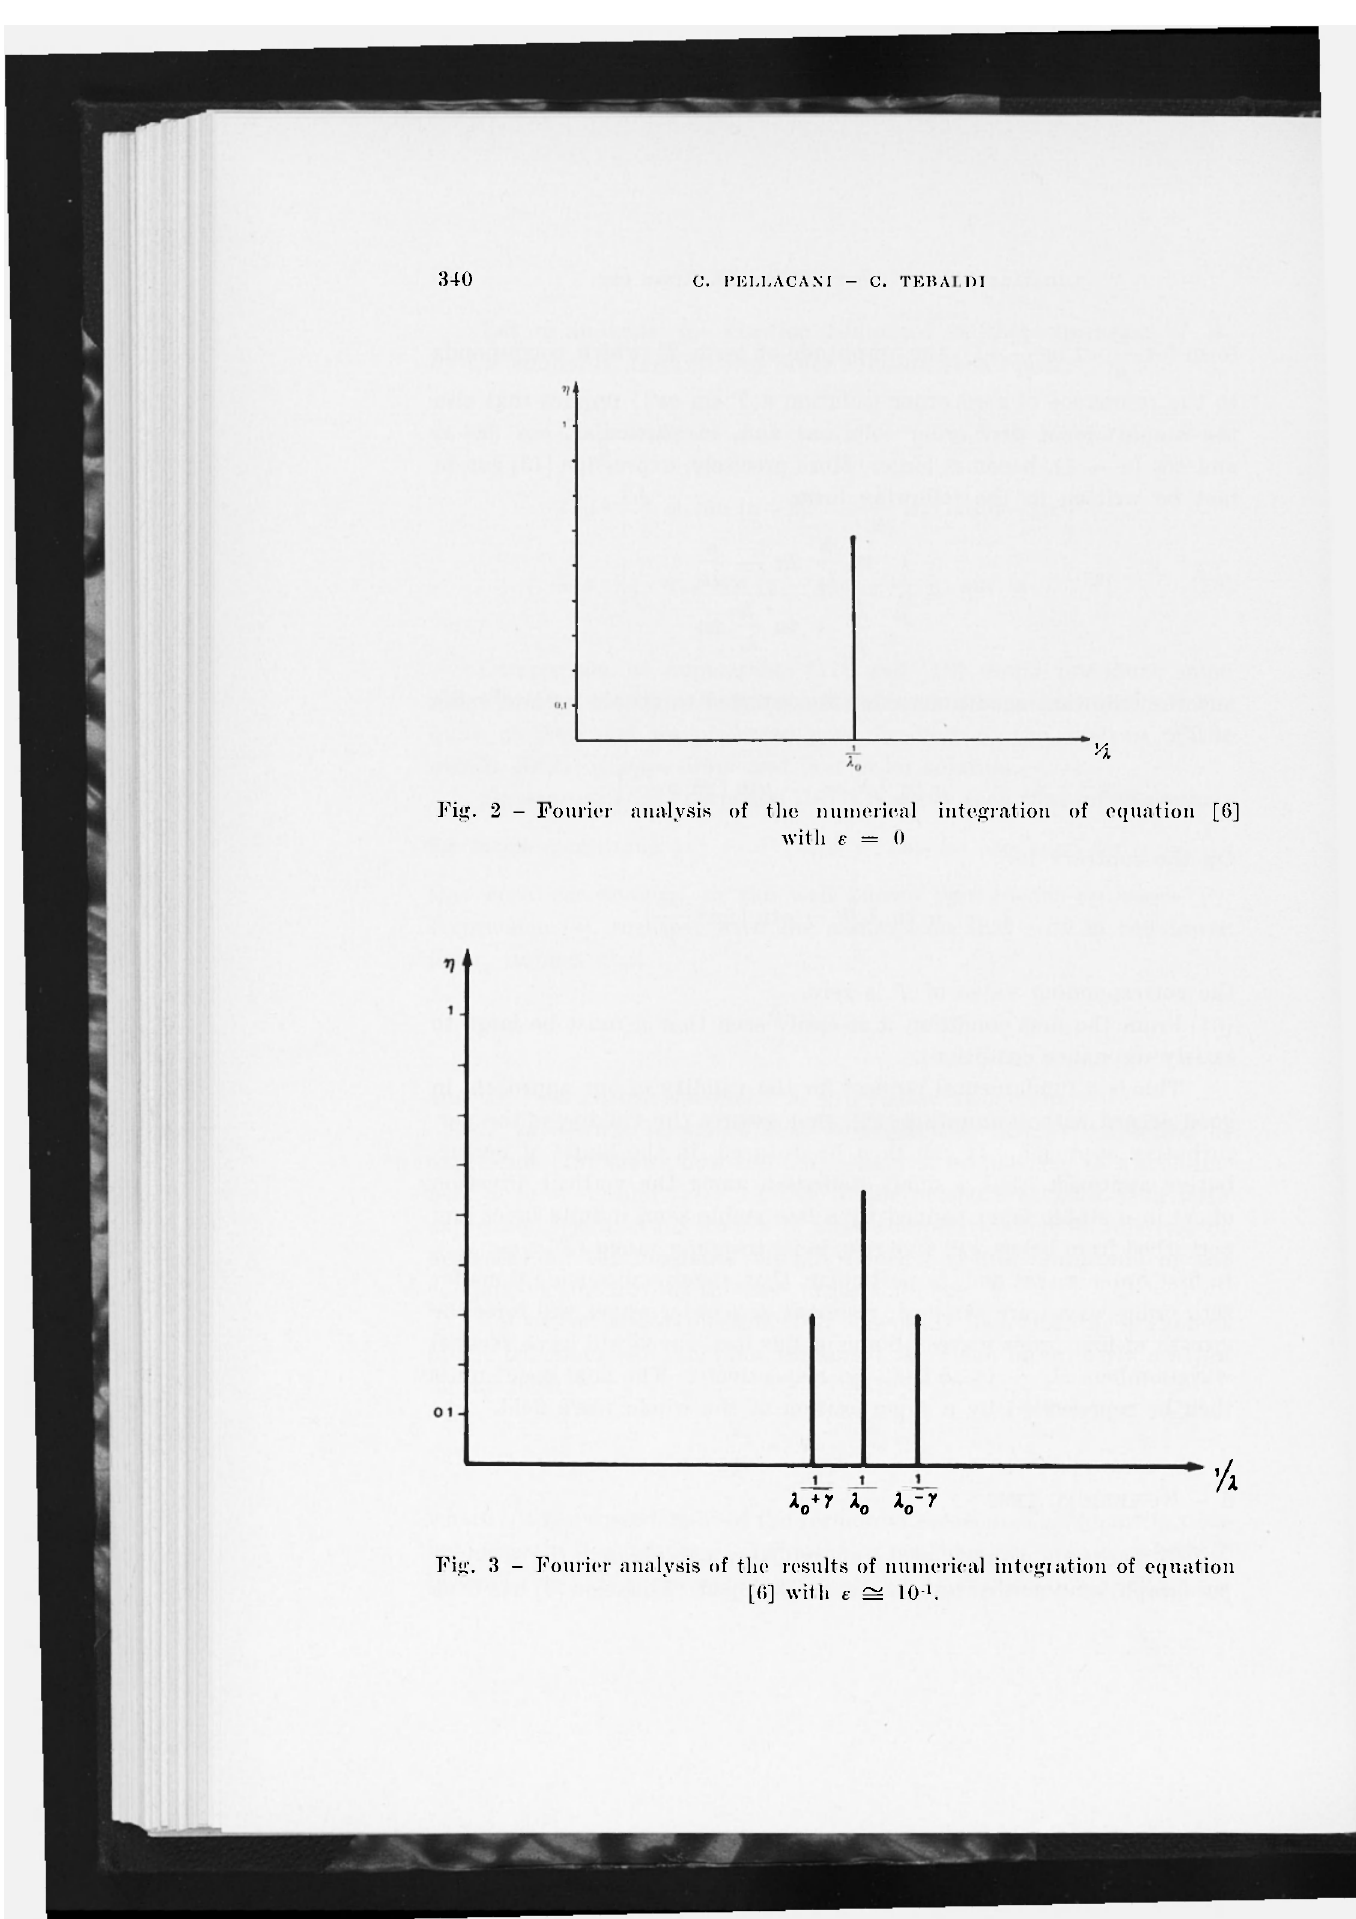
Fig. 3 - Fourier analysis of the results of numerical integration of equation [6] with e ^ 10